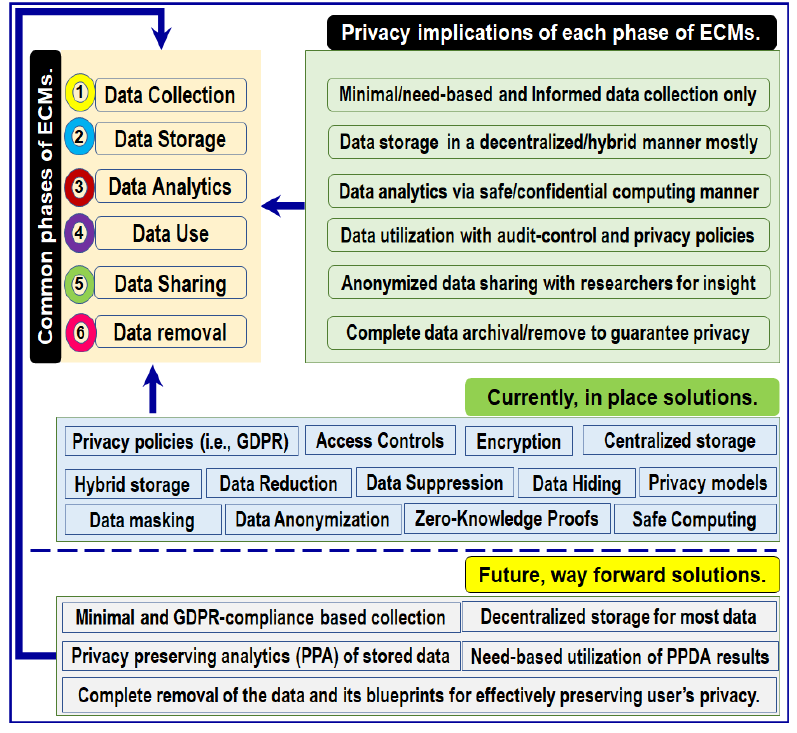
Figure 4. Overview of the taxonomy of privacy preservation in epidemic control measures, present solutions and way forward (future